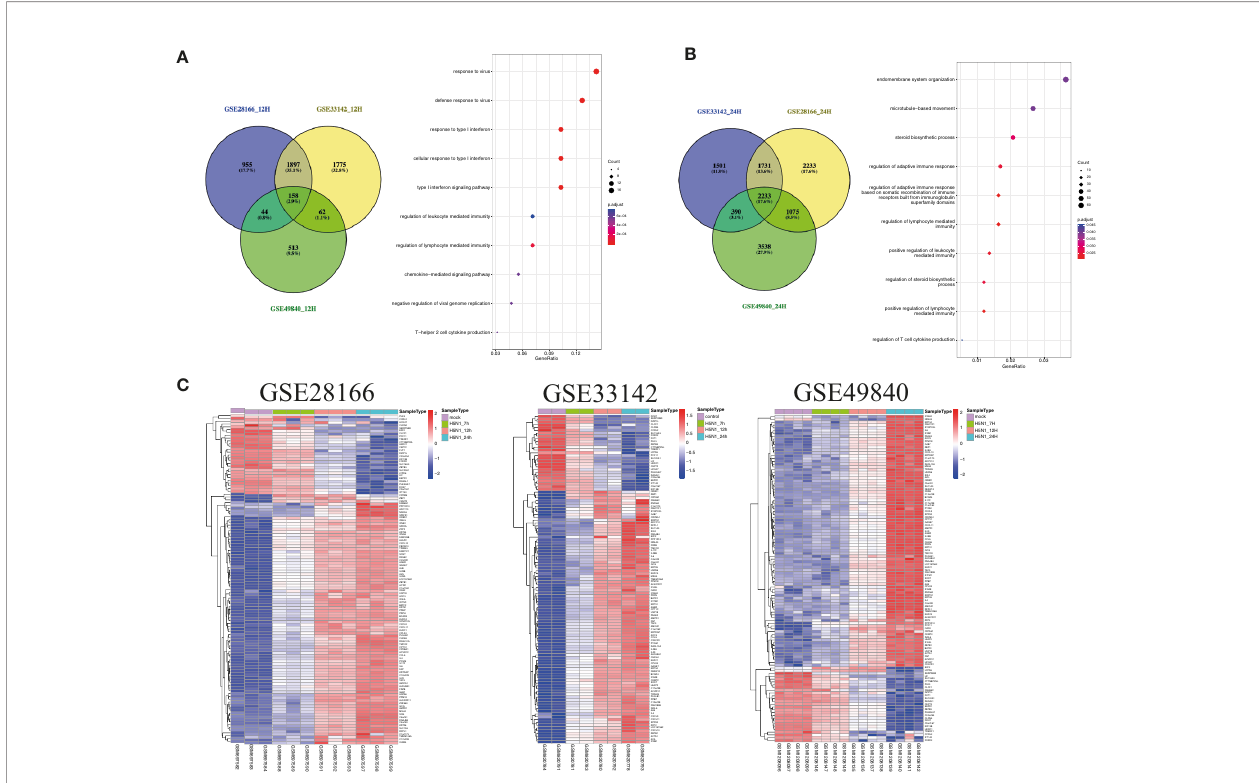
FIGURE 3 | The common gene expression from three different data series in Calu-3 cells infected with H5N1. (A) A Venn diagram of the overlap genes between different data with 12 hpi. A total of 158 genes were common to the four H5N1-infected Calu-3 cells at 12 hpi; KEGG pathways of differentially expressed overlap genes. The vertical axis shows the number of genes, and the horizontal axis shows the GeneRatio. (B) A Venn diagram of the overlap genes between different data with 24 hpi. In total, 2233 overlapped genes were common to the four H5N1-infected Calu-3 cells at 24 hpi. KEGG pathways of differentially expressed overlap genes. The vertical axis shows the number of genes, and the horizontal axis shows the GeneRatio. (C) Heatmap of differentially expressed patterns of the overlap genes in IAV-infected Calu-3 cells. Row represents the overlap genes and each column corresponds to a